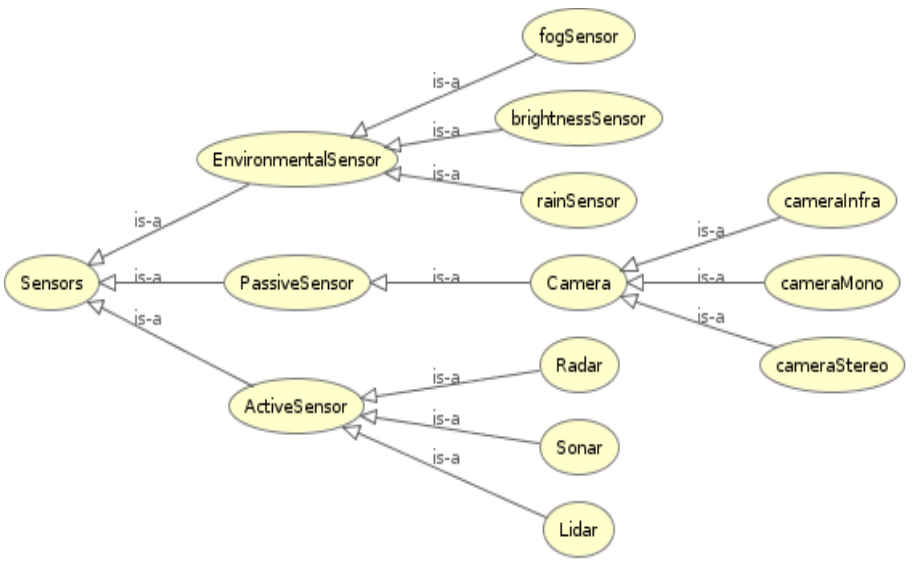
Figure 2. Class and subclasses of